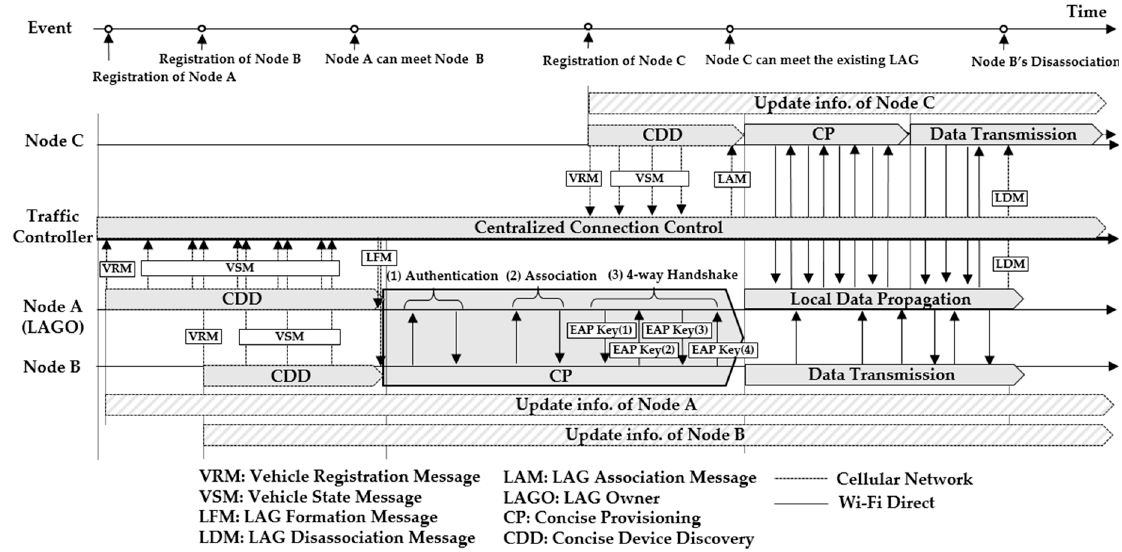
Figure 1. Overview of the proposed hybrid V2V communication system.